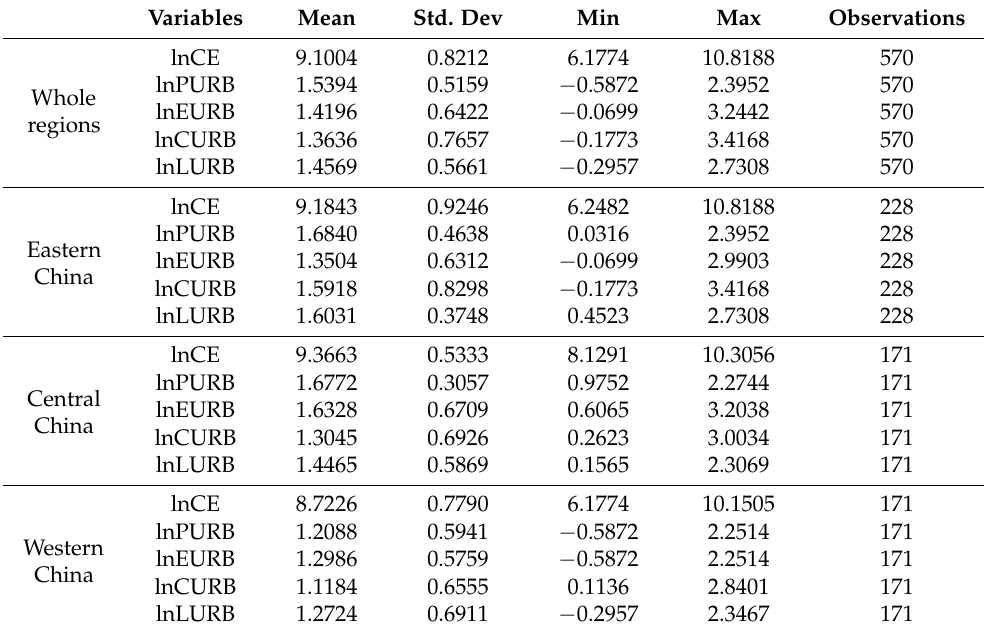
Table 2. Statistics description of carbon emission and four-dimension urbanizations.